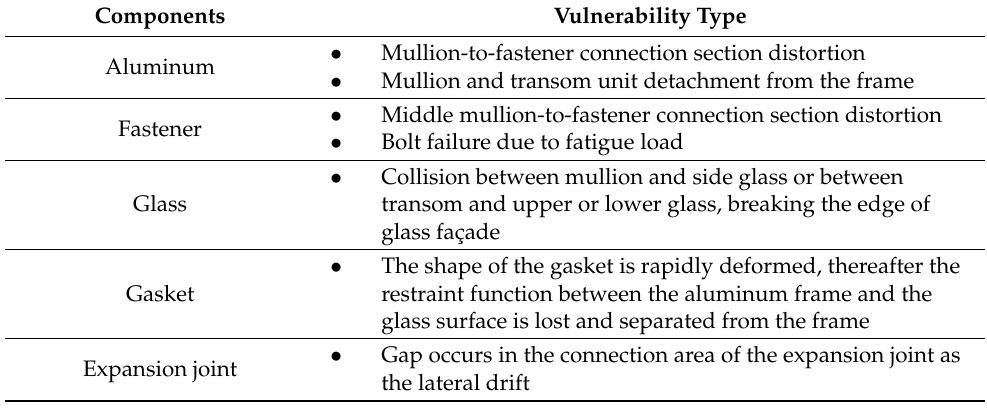
Figure 18. Response of the conventional curtain wall under static lateral drift.